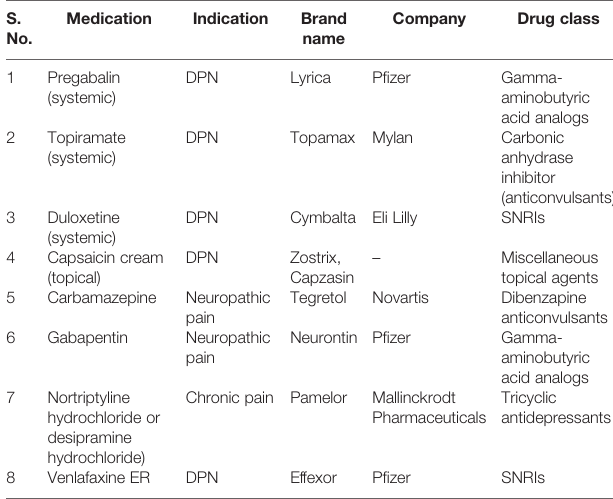
TABLE 1 | Marketed drugs for alleviating diabetic neuropathic pain